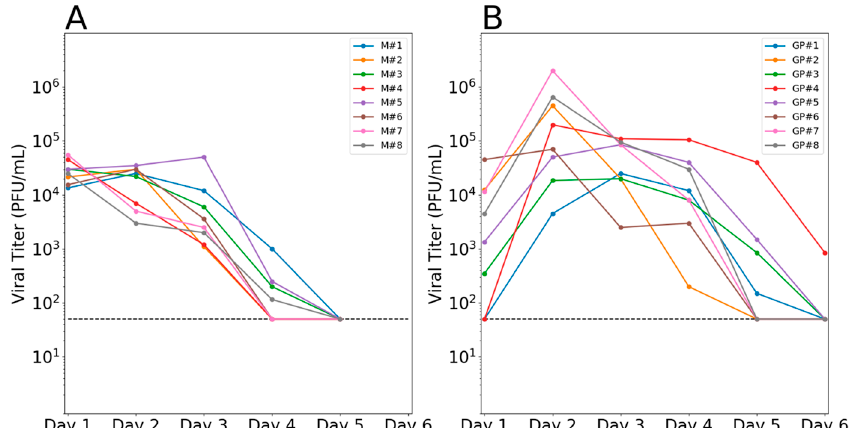
Figure 1. Efficient viral replication was observed in mallards and guinea pigs. Infectious viral titers in ( A ) cloacal swab samples collected from mallards and ( B ) nasal lavage samples collected from guinea pigs are plotted against day post-inoculation. Each colored line represents an individual animal. Horizontal dashed line shows the limit of